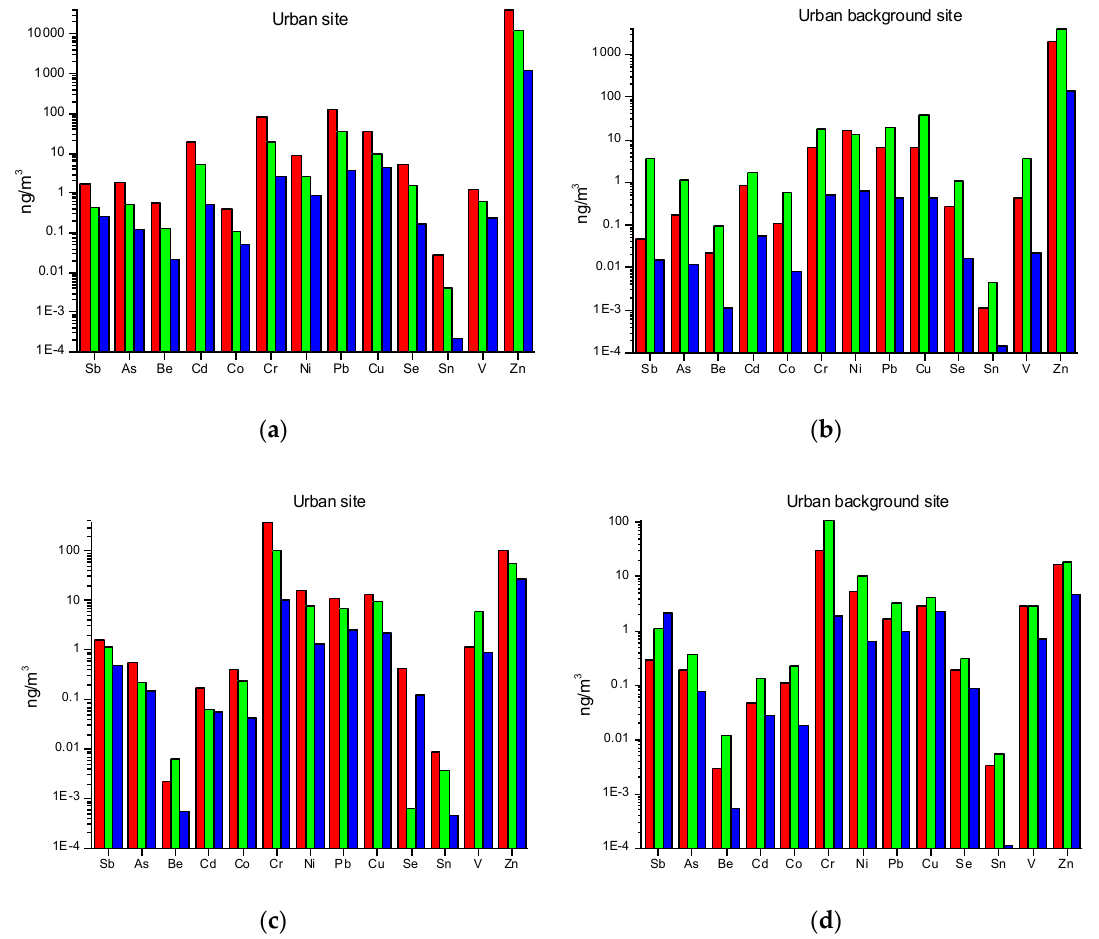
Figure 5. Metals and metalloids in PM 10 and PM 2.5 in the ( a , c ) Urban Site and ( b , d ) Urban Background, respectively—both the PM fractions highlight the presence of many anthropogenic elements; it is also worth noting the predominance of Cr tot , in the PM 2.5 fraction in both sampling sites, which can be associated to coal combustion (red: sector #1; green: sector #2; blue: sector #3). For a comparison of concentration values measured regulated metals (As, Cd, Ni and Pb) with limit established by regulation, it must be taken into account the di ff erent sampling methods used with those defined by law. For the regulated metals, it is possible a comparison only for determinations on the PM 10 fraction, even though the integration time of PM 10 in this study is on monthly average and not daily as